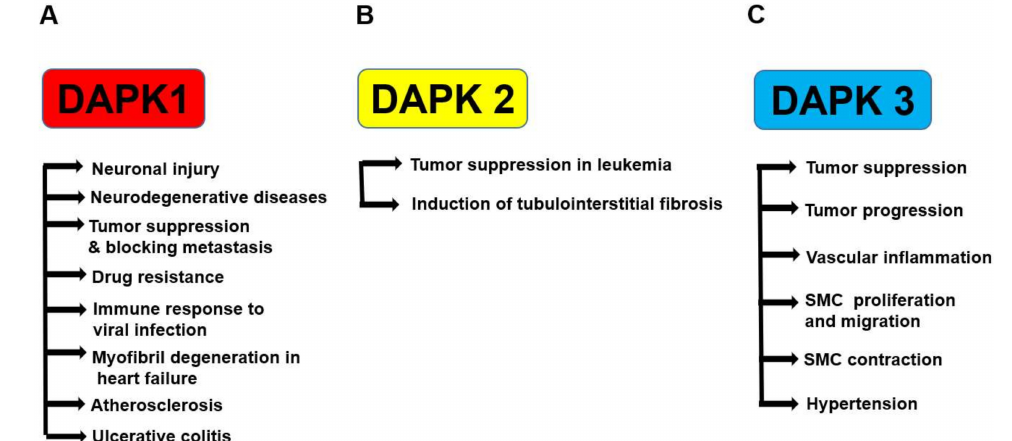
Figure 2. Roles of DAPK family proteins in various diseases. DAPK1 regulates neuronal injury, neurodegenerative diseases, tumor suppression, metastasis blocking, resistance to anti-cancer drugs, immune response during antiviral infection, myofibril degeneration in heart failure, atherosclerosis, and ulcerative colitis ( A ). DAPK2 regulates tumor suppression in leukemia and induction of tubulointerstitial fibrosis ( B ). DAPK3 regulates tumor suppression or progression, vascular inflammation, smooth muscle cell (SMC) proliferation and migration, SMC contraction, and hypertension ( C